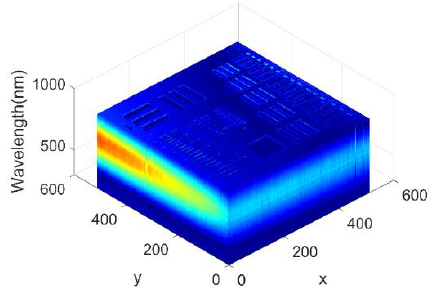
Figure 8. The hyperspectral data cube of the resolution chart.